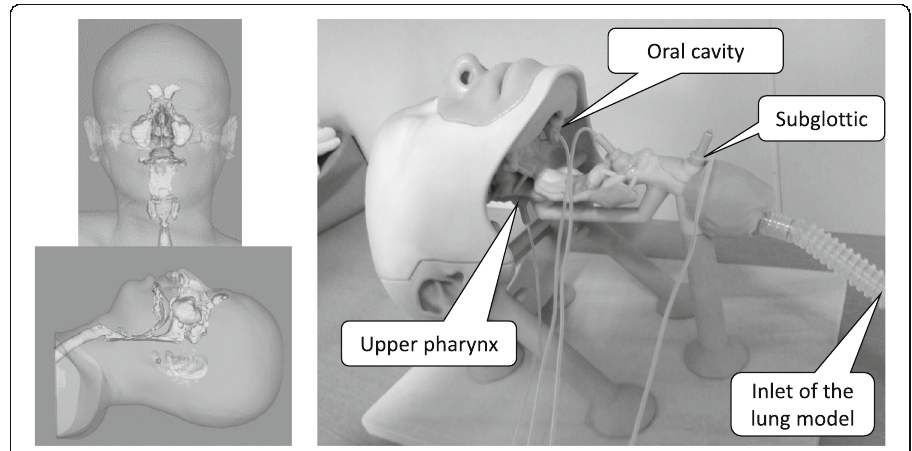
Fig. 1 The airway model. The actual airway model was made by a 3D printer using 3D-CT data. Sampling ports were made to record capnograms at each site in the model